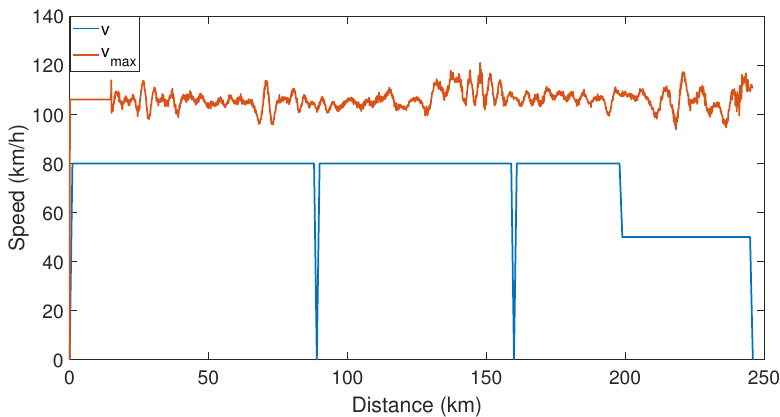
Figure 16. Speed profile of the route Chiriguaná – Santa Marta with S-334 locomotive.